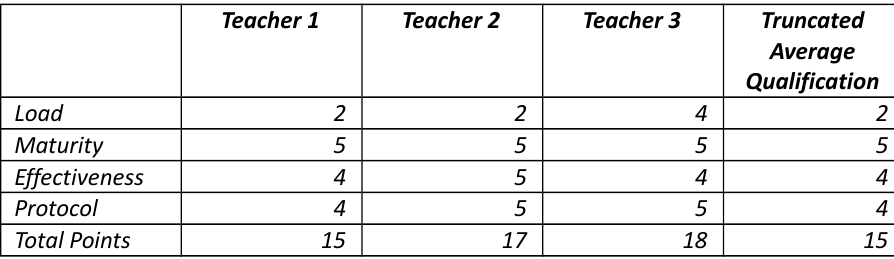
Table 2. Evaluation of the fundamental aspects (Load, Maturity, Effectiveness and Protocol) of the autonomous learning